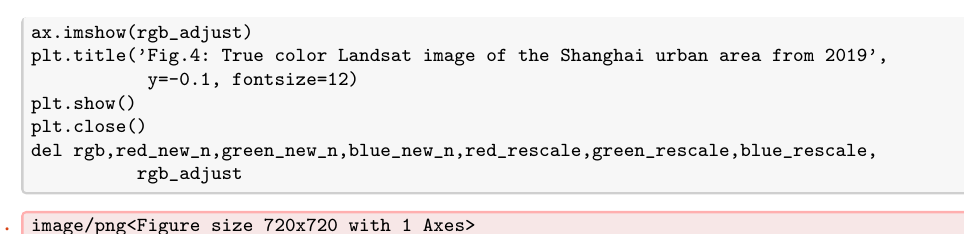
Figure 4: True colour Landsat image of the Shanghai urban area from